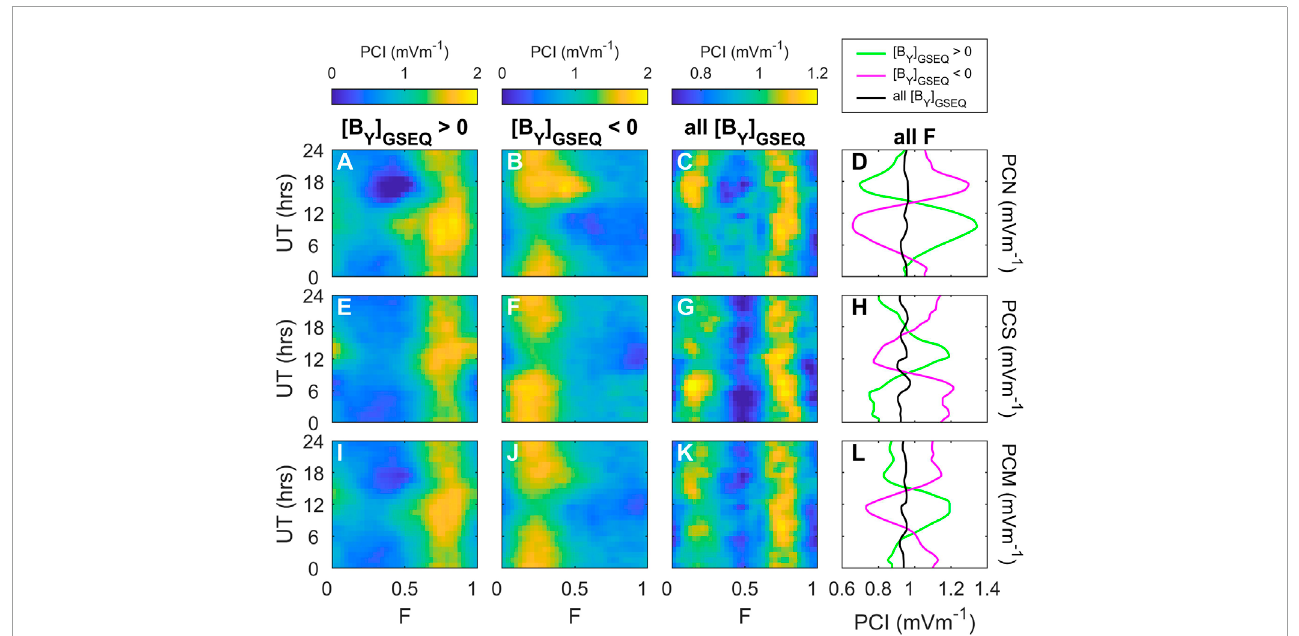
FIGURE 11 Definitive, IAGA-endorsed Polar Cap Index ( PCI ) data for 1998–2020, inclusive. The top row is for the Northern polar cap index, PCN , the middle row is for the Southern polar cap index, PCS , and the bottom row is for the average of the two (labelled, PCM : “M ′′ for “Mondiale” (global) to match the am index terminology). The first three columns (left to right) show F - UT , plots. The first is for [ B Y ] GSEQ > 0, the second for [ B Y ] GSEQ < 0 and the third for all [ B Y ] GSEQ . The right hand plots shown the averages of the index over all F as a function of UT : the green line is for [ B Y ] GSEQ > 0, the mauve line for [ B Y ] GSEQ < 0 and the black line for all [ B Y ] GSEQ .